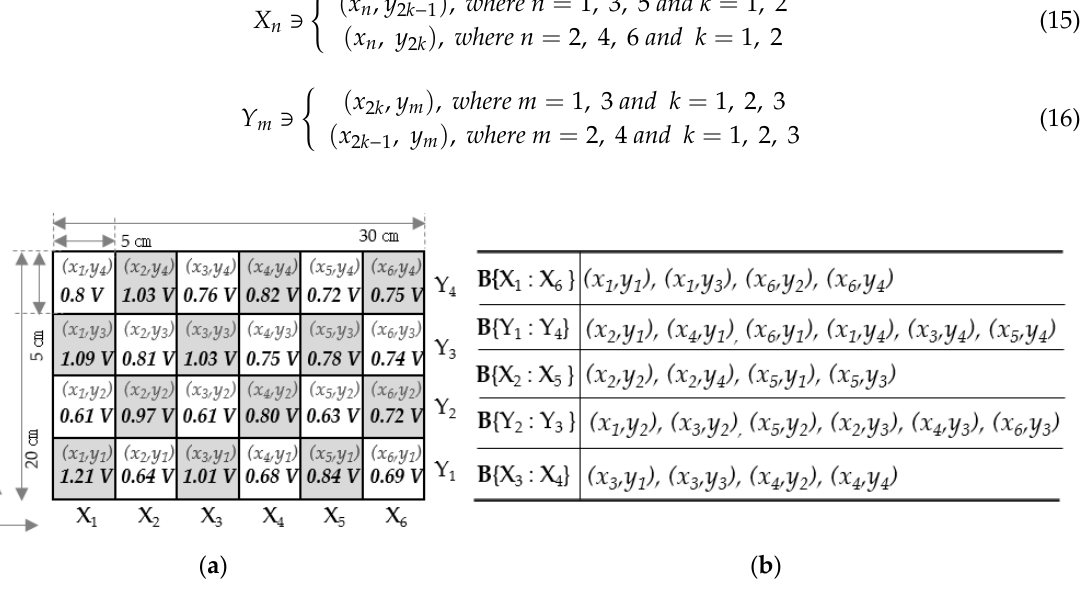
Figure 10. ( a ) Coordinates to indicate the position of the coin and the zero-to-peak value of V AB measured at each position, and ( b ) the balanced coil set and the position of the loop coil belonging to the set.